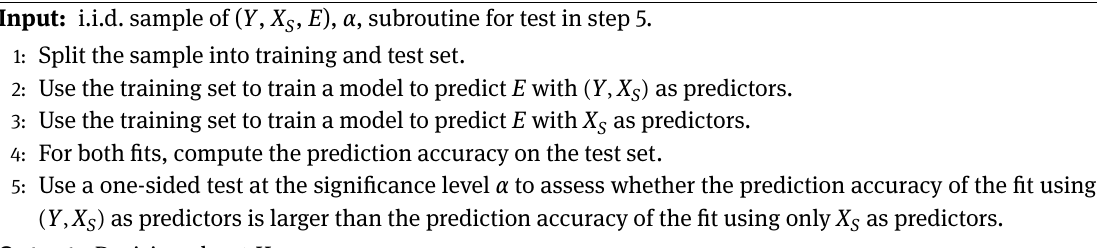
Algorithm 3 Invariant environment prediction for nonlinear